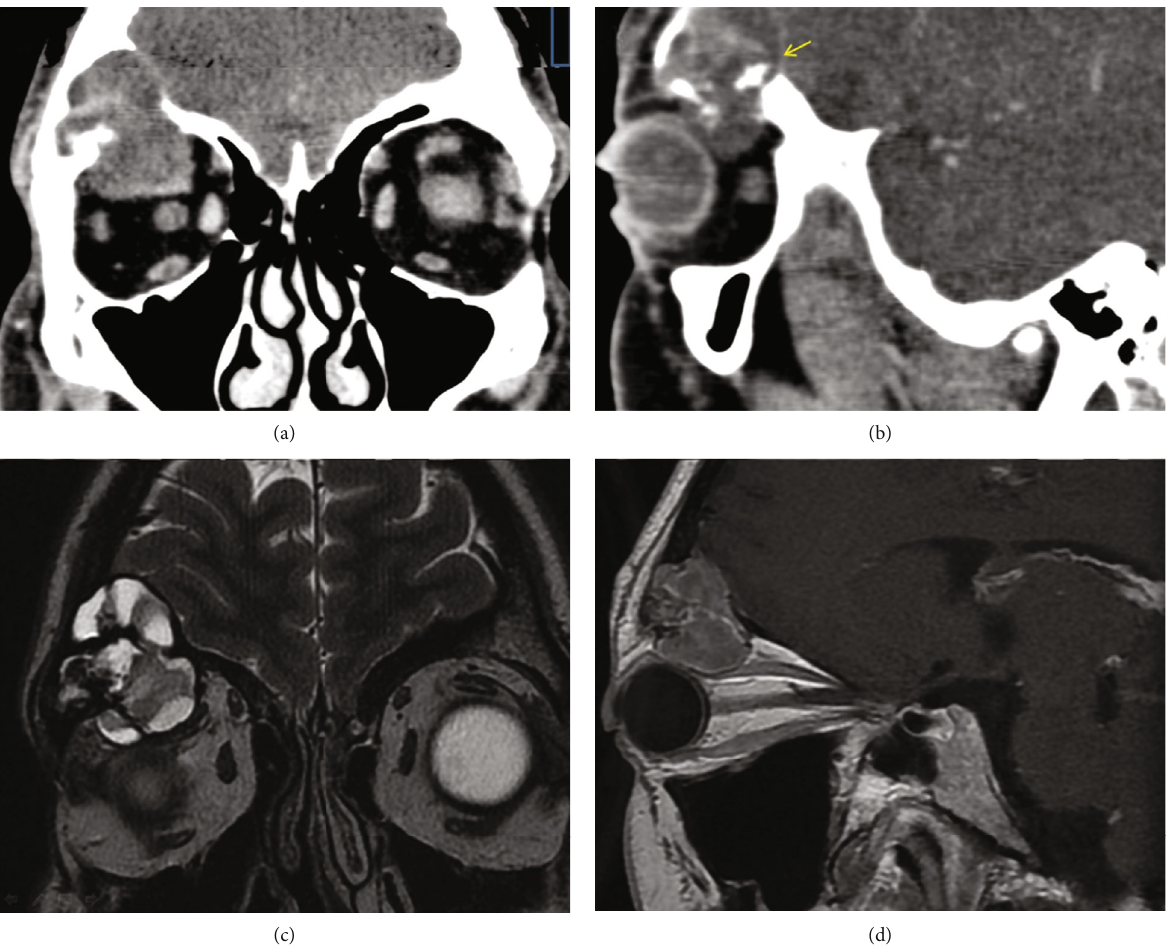
Figure 1: (a, b) Contrast-enhanced coronal and sagittal CT images, demonstrating an expansive lesion arising from the roof of the right orbit with a heterogeneous enhancement and soft tissue attenuation. Inside view of the lesion reveals several small foci of mineralization (arrow). The lesion shows the osseous expansive changes, with thinning of superior and inferior wall of the roof which leads to an invasion over the frontal sinus and into the orbit. (c) Coronal T2-weighted MRI shows a well-de fi ned lesion with a low-signal-intensity margin representing either osseous sclerosis or a pseudocapsule. The lesion shows a multilobulated lytic pattern which reveals markedly increased signal intensity, re fl ecting the expansive cystic component, and low signal intensity in the small solid regions. (d) Sagittal postcontrast T1- weighted MR image shows a well-encapsulated mass with homogenous contrast